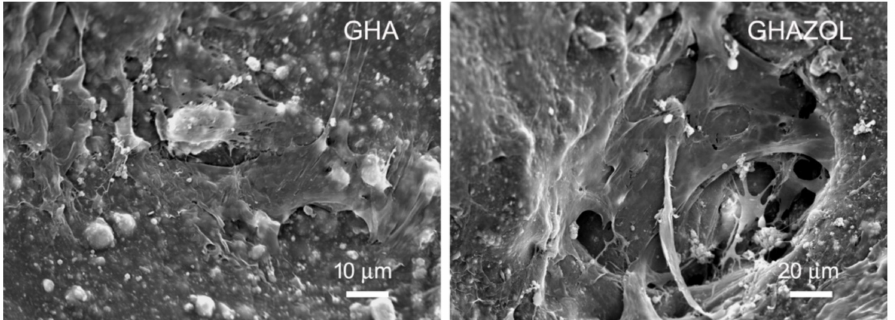
Figure 5. SEM micrographs of hMSC grown after 10 days of culture on the inner layers of GHA and GHAZOL inserts. Scale bars: 10 and 20 µ m for GHA and GHAZOL, respectively. Magnifications: 1000 × and 500 × for GHA and GHAZOL,